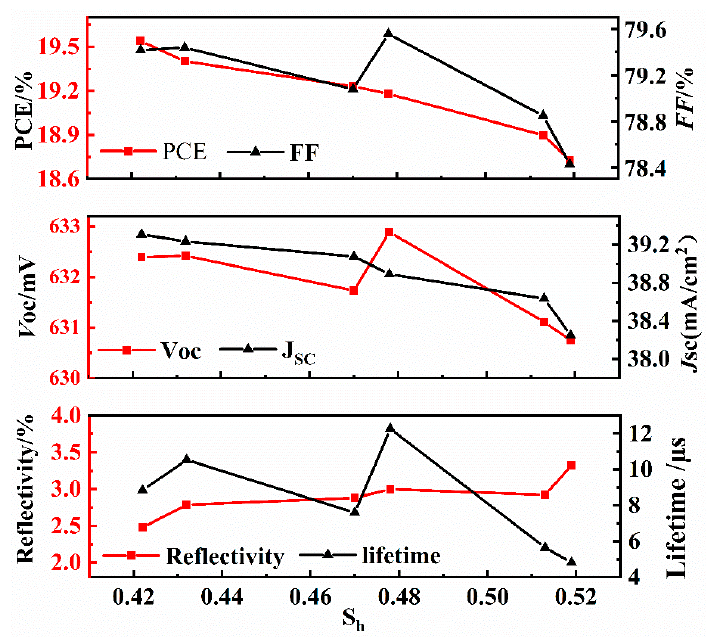
Figure 10. Relations between the relative standard deviation and photoelectric characteristics.